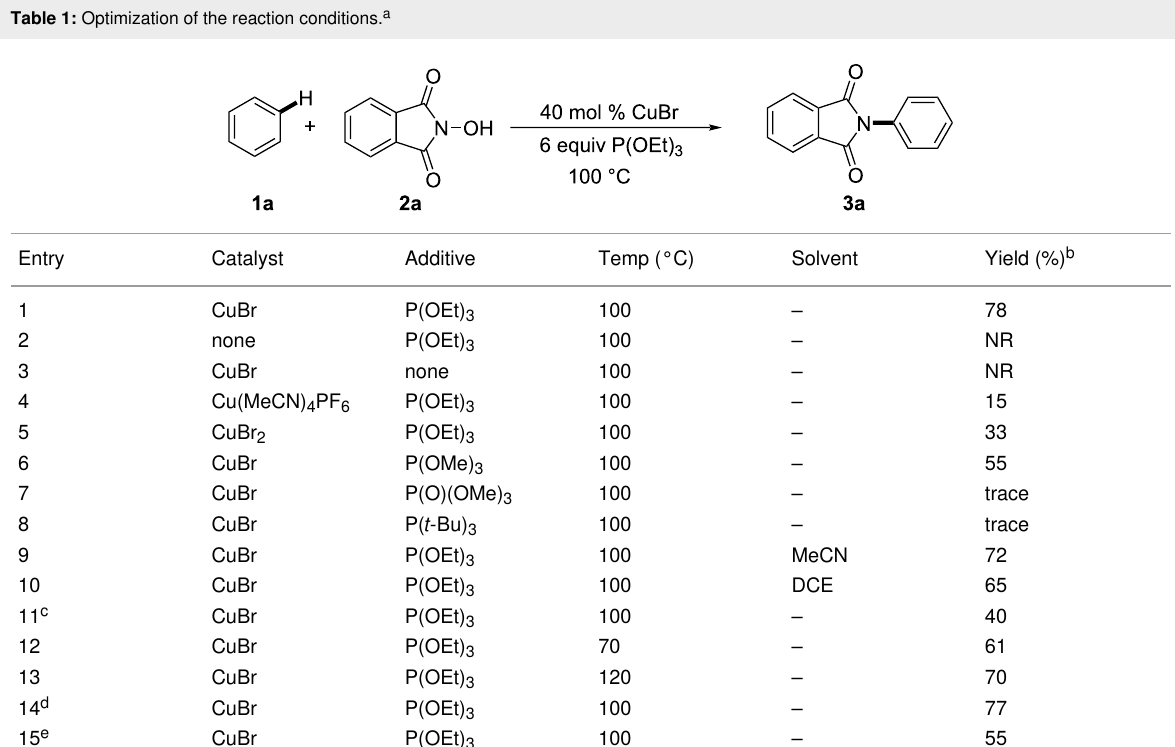
Table 1: Optimization of the reaction conditions.